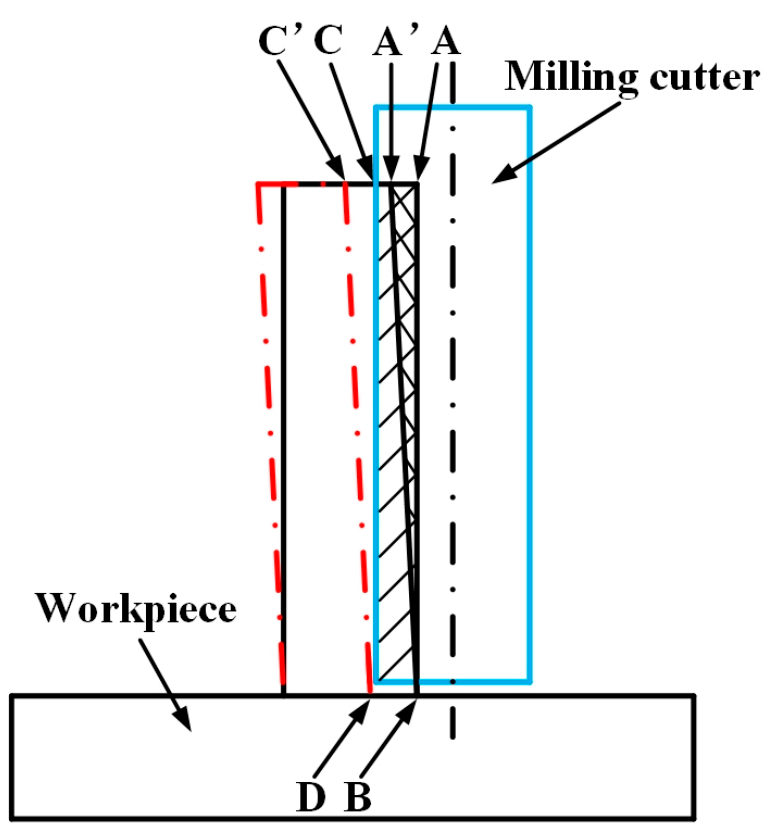
Figure 1. Error in thin wall machining.